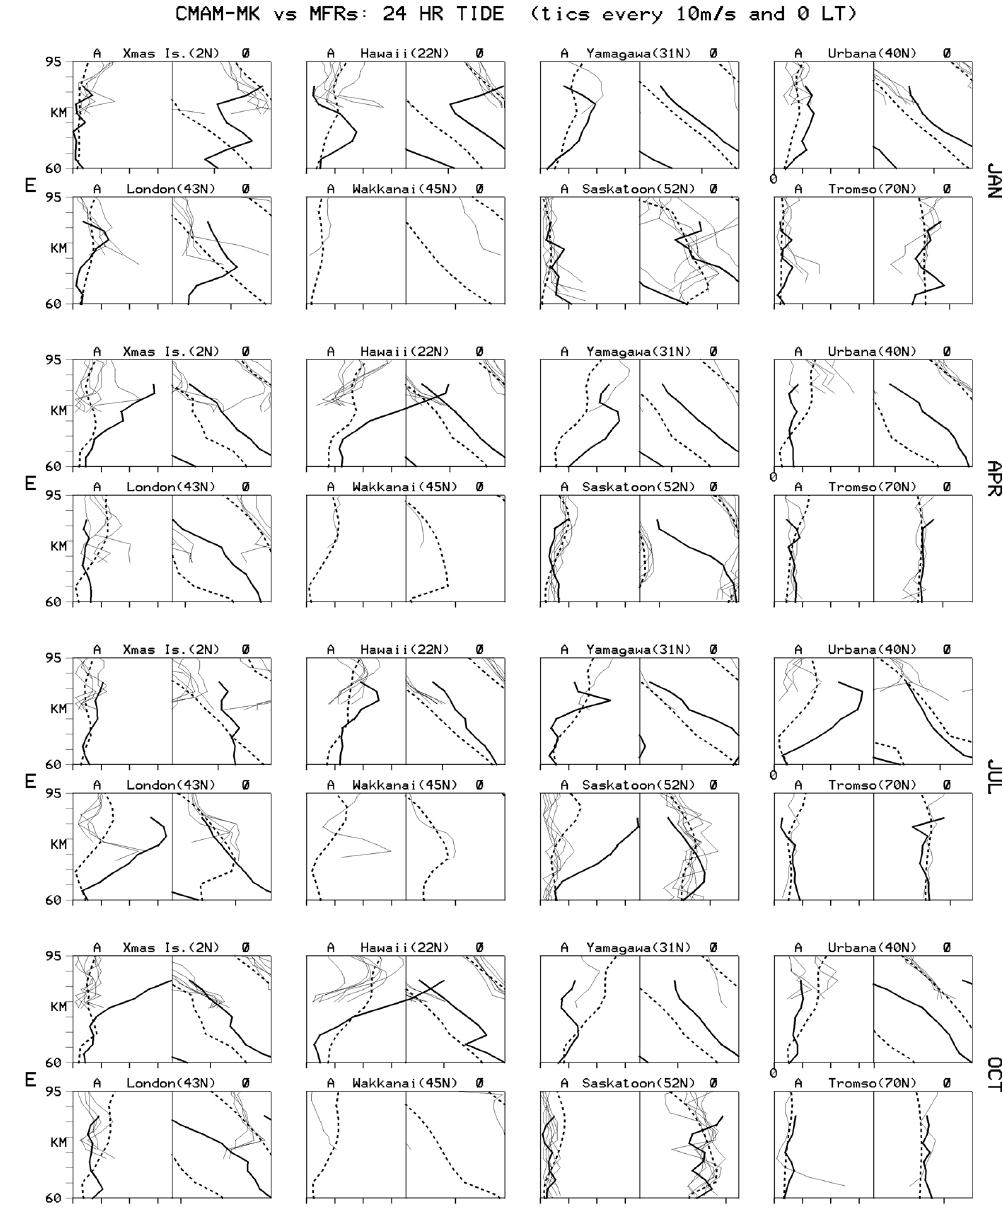
Fig. 12. Comparisons between the Diurnal (24h) Tide profiles for the MFR and GSWM. Otherwise as for Fig. 11.